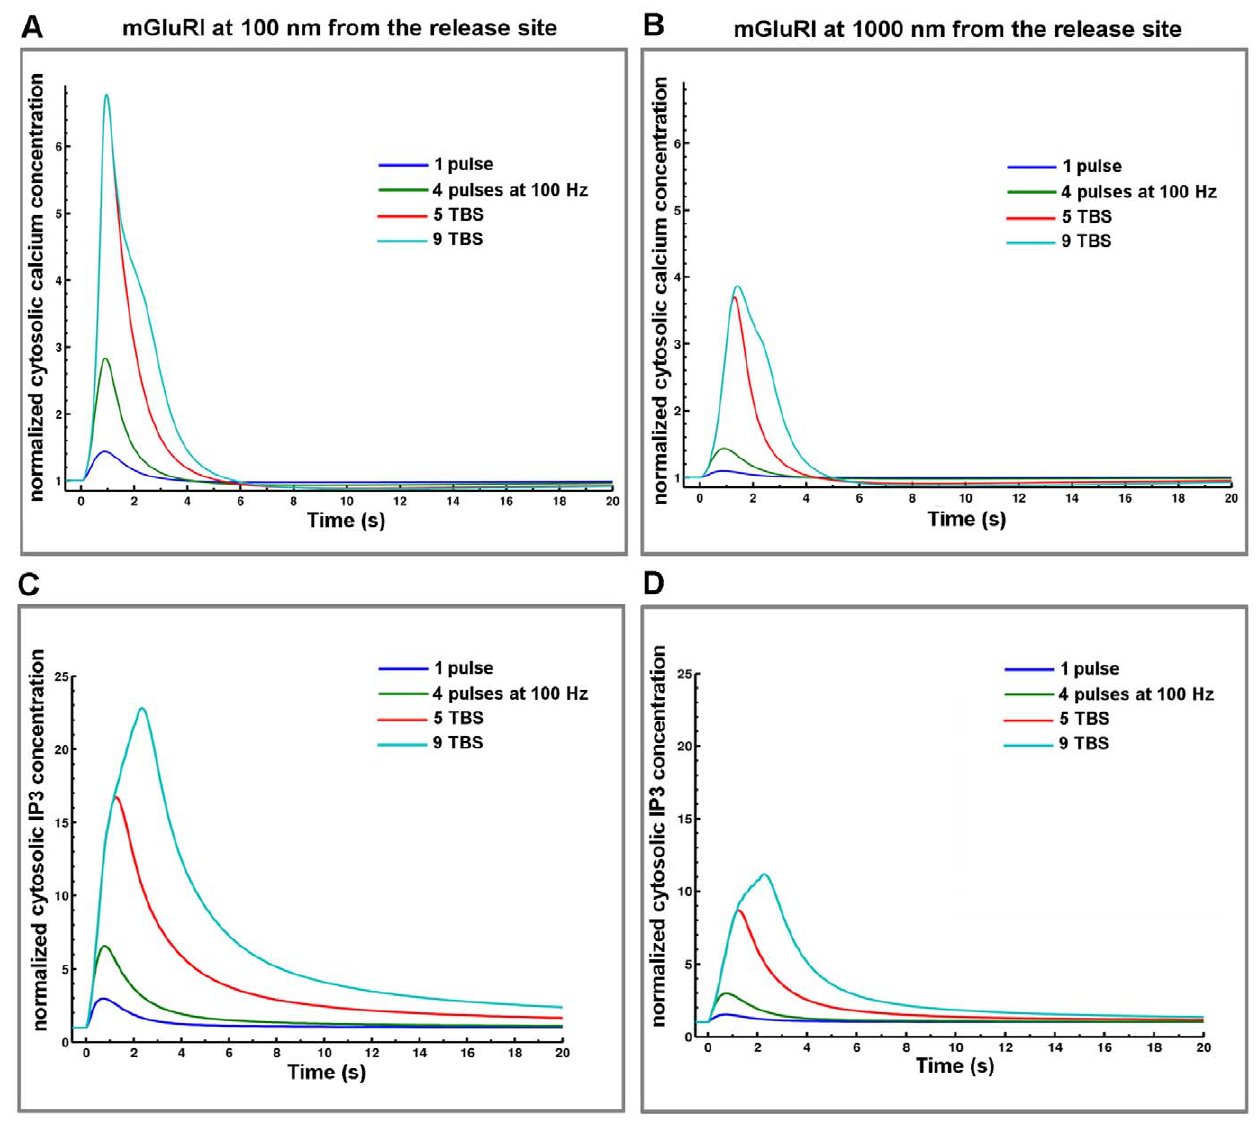
Figure 5. mGluRI-mediated changes in cytosolic calcium and IP3 concentrations for various stimulation patterns and different locations. (A, B) Temporal evolution of cytosolic calcium concentration generated by mGluRI activation in response to one release event, one burst (four releases at 100 Hz), 5 and 9 TBS (5 or 9 bursts with 200 ms delay between each) with mGluRI at 100 nm (A) or 1000 nm (B) from the release site. Peak response was reached with 5 TBS and increasing the number of TBS only modified decay kinetics. Calcium responses were normalized to the value of basal cytosolic calcium concentration (60 nM). (C, D) Temporal evolution of cytosolic IP3 concentration generated by mGluRI activation in response to the same patterns of stimulation as in A and B, with mGluRI at 100 nm (C) or 1000 nm (D) from the release site. IP3 responses were normalized to the value of basal cytosolic IP3 concentration (100 nM).